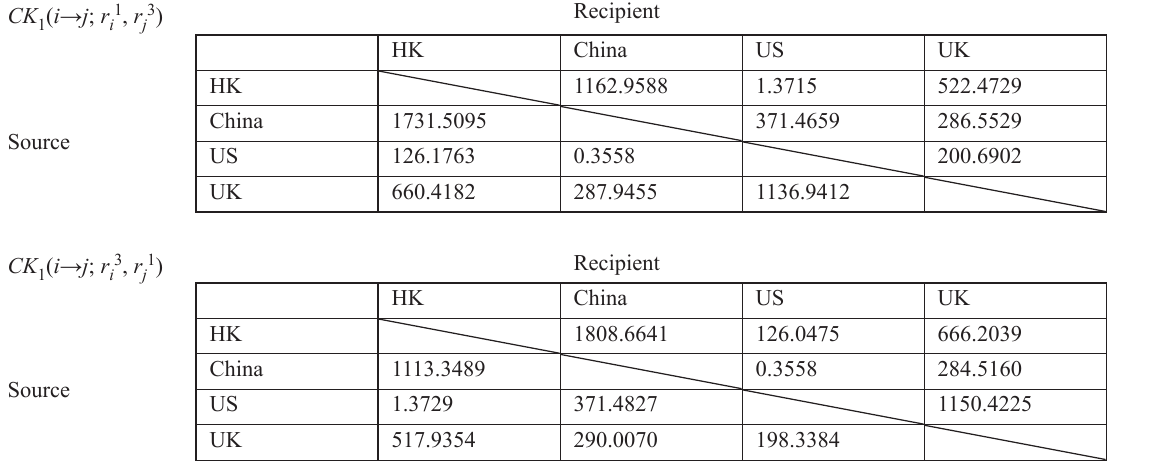
s . the 5% critical value is , i t